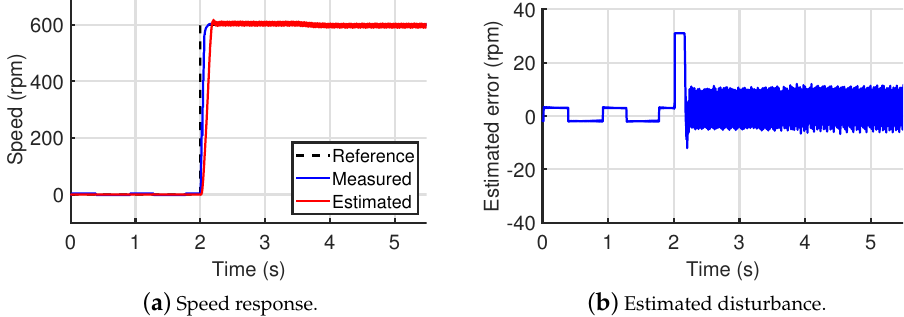
Figure 16. Experimental results of SMO at 600